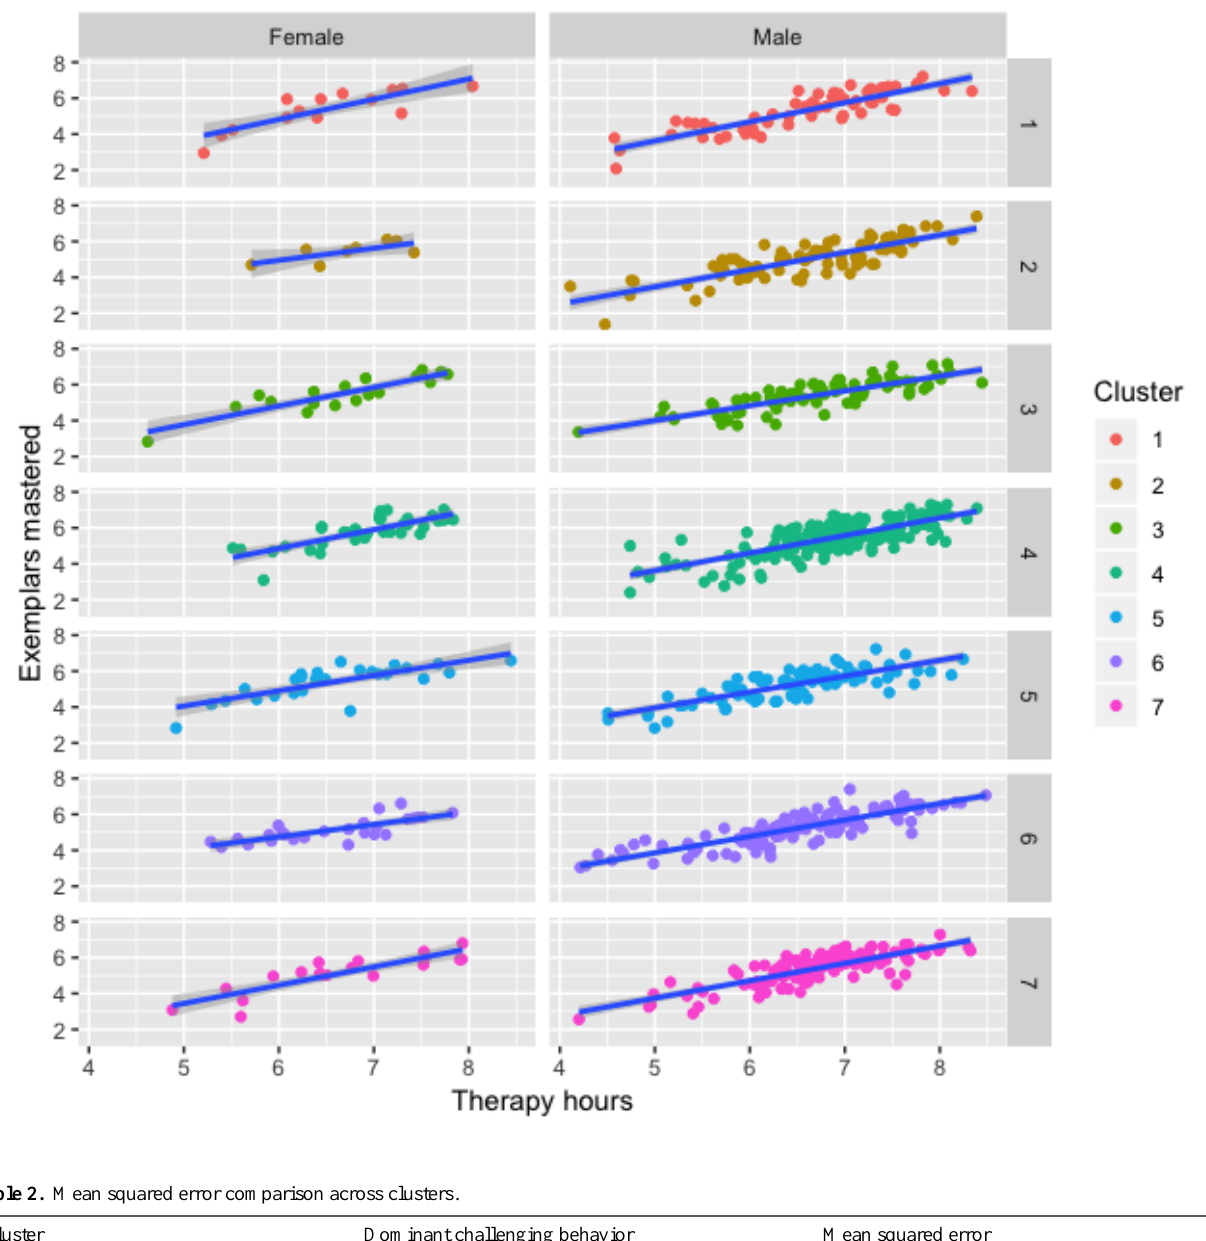
Figure 4. The line of best fit for each gender and cluster.